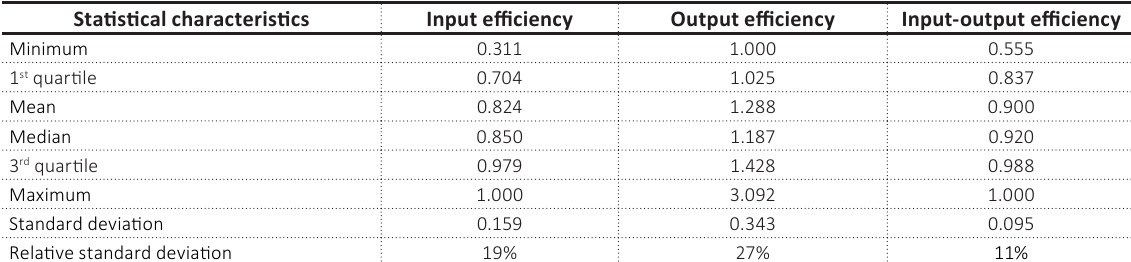
Table 2. Main statistical characteristics of efficiency values based on the average of the years